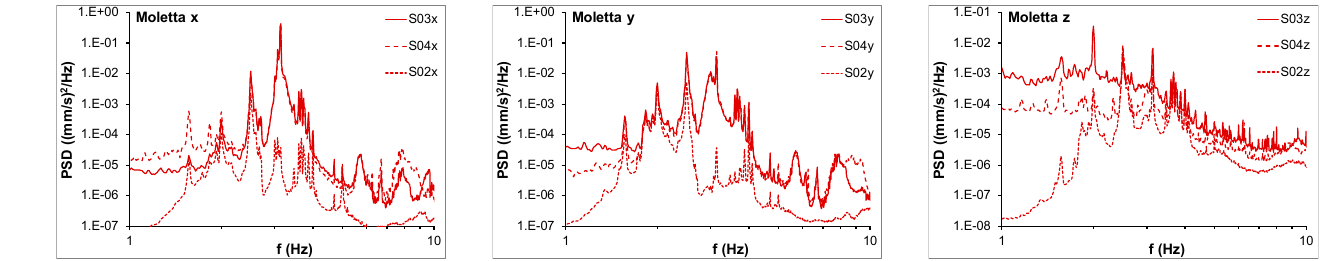
Figure 5. Time histories recorded at the base (S02x) and at the top (S04x) of the Torre della Moletta in the x direction. Figures 6 and 7 show the power spectral density (PSD) graphs of all the recordings for the entire time length for the three directions obtained on the Torre della Moletta and on the soil, respectively. Several peaks can be observed between 2 and 4 Hz. These peaks are apparent, especially in the recordings of the Torre della Moletta. The often good correlation between the measurements at the various locations is related to the presence of buried structures.